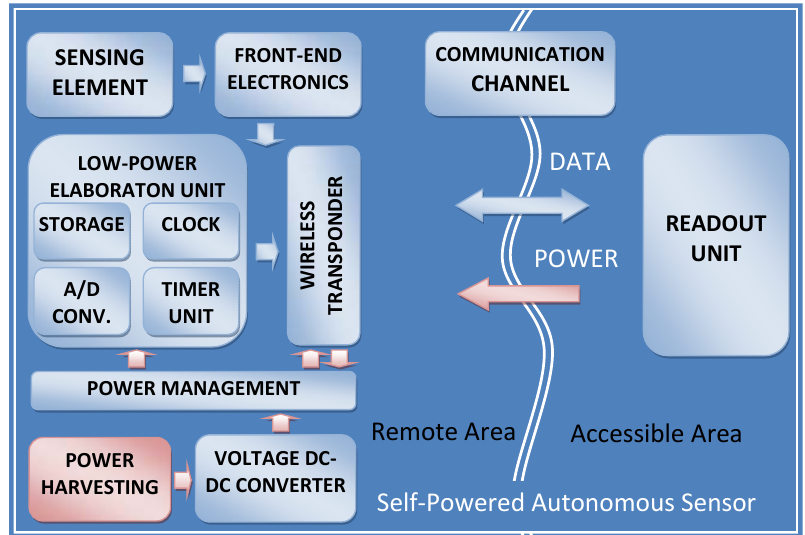
Figure 3. Block diagram of self-powered autonomous sensors.